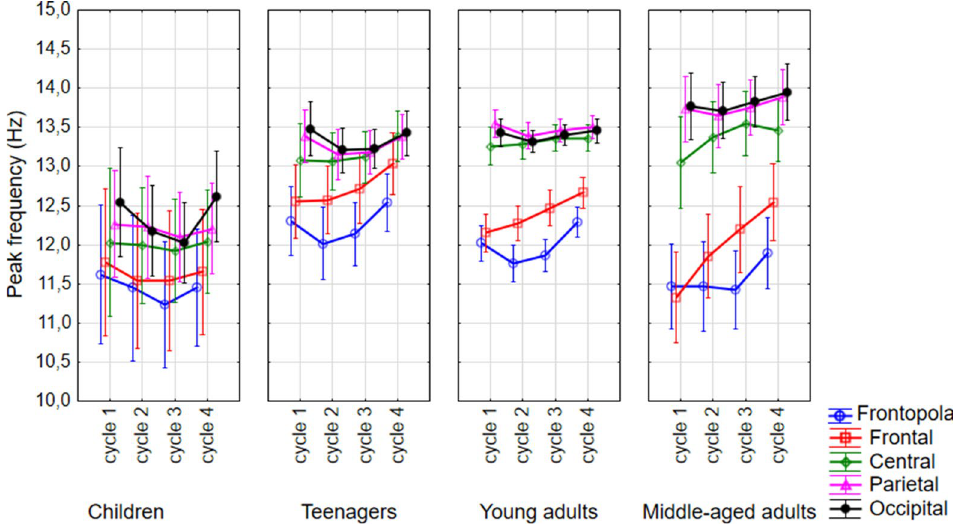
Figure 6. Cycle dynamics of the frequencies of the maximal peaks in the spindle range. Dots are group mean values, whereas vertical bars denote 95% confidence intervals.